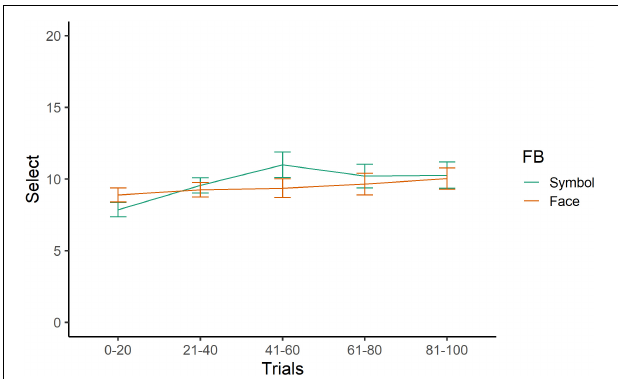
FIGURE 2 | Learning curves for social and monetary feedback. Line plots represent means, and error bars represent standard errors. The y -axis indicates the number of advantageous decks that the participants